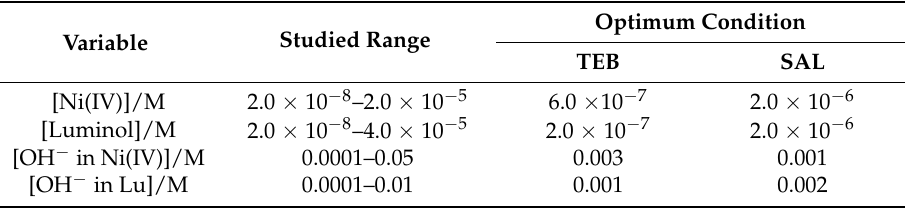
Table 1. Optimization of CL conditions for the TEB and SAL